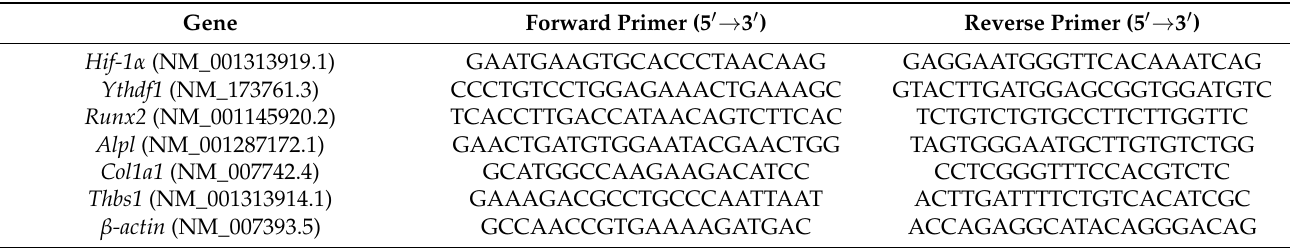
Table 2. Primer sequences for